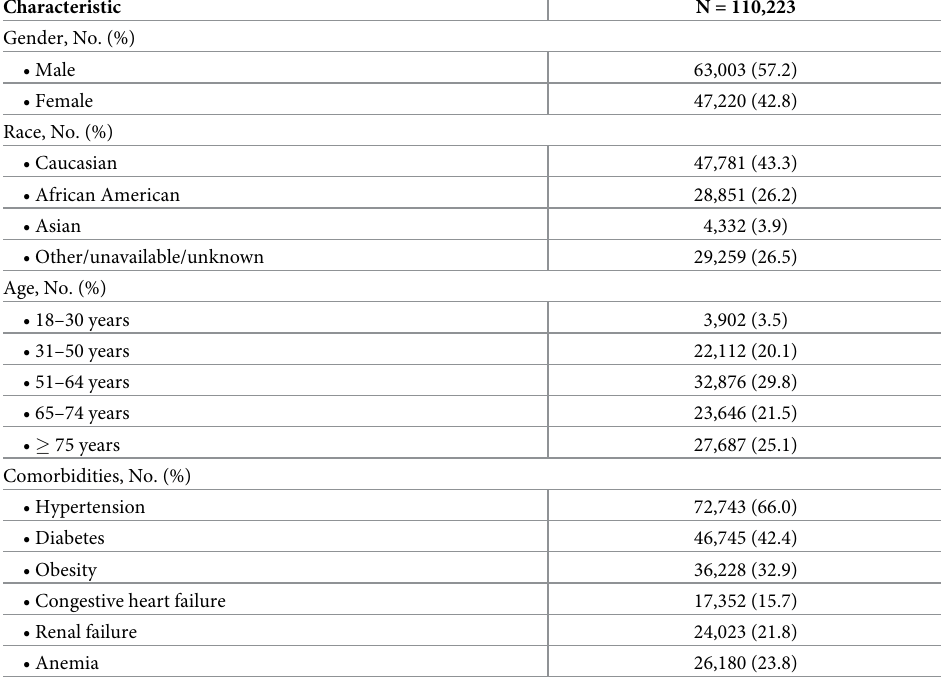
Table 1. Demographics and comorbidities of adults with COVID-19 and acute respiratory distress syndrome or acute respiratory